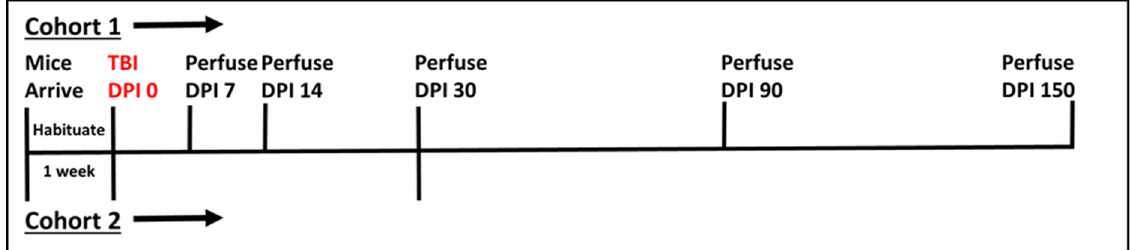
Figure 1. Timeline of experimental procedures. Cohort 1 was our initial experimental cohort with all mice experiencing TBI on the same Day (DPI 0), and subgroups perfused at each timepoint noted. Due to the loss of some tissue samples from cohort 1, however, a second cohort (Cohort 2) was added to the 30 DPI time point. Vertical Lines above the horizontal indicate Cohort 1 while those below the horizontal line are associated with Cohort 2.